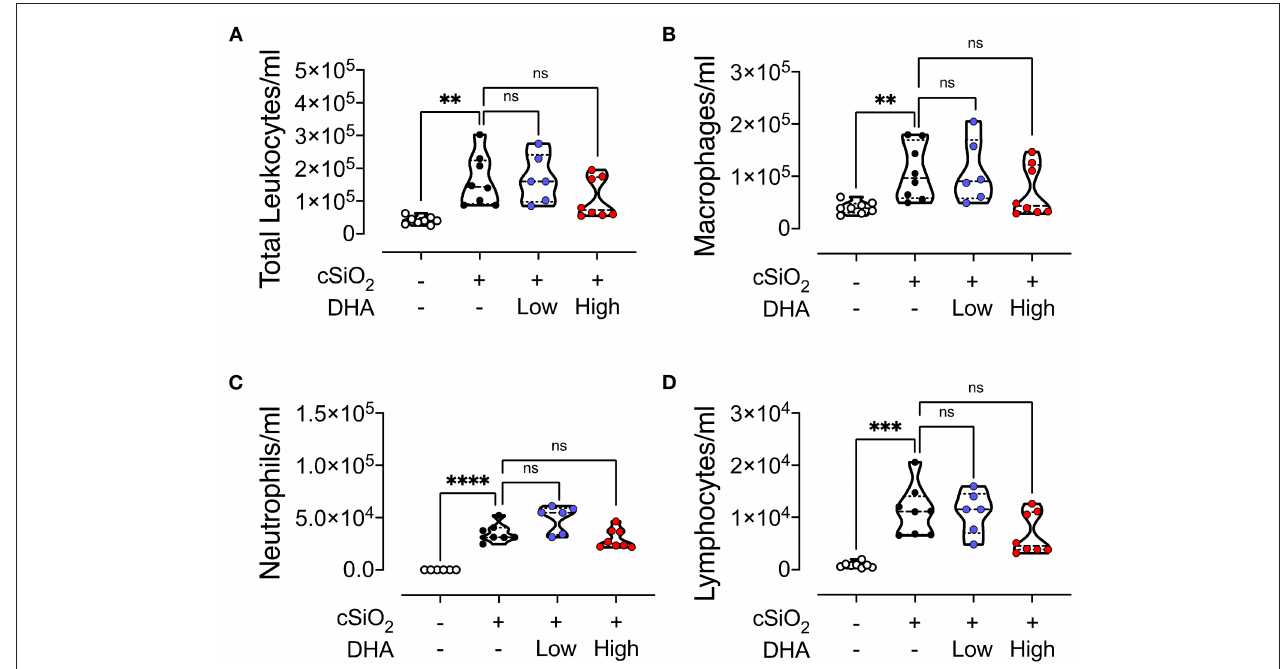
FIGURE 4 | cSiO 2 -induced inflammatory cell recruitment into the lungs is modestly attenuated by DHA feeding. 13 week following the final cSiO 2 instillation, mice were necropsied and BALF collected. The BALF cell fraction was assessed for (A) total cells, (B) macrophages, (C) neutrophils, and (D) lymphocytes as measures of inflammatory cell recruitment. cSiO 2 significantly increased the number of each cell type in the BALF. Total leukocytes, macrophages, and lymphocytes appeared to be slightly reduced by the high DHA diet, though the difference was not significant. Statistical comparisons were performed as described in the Methods section. **** p ≤ 0.0001, *** p ≤ 0.001, ** p ≤ 0.01, ns = not